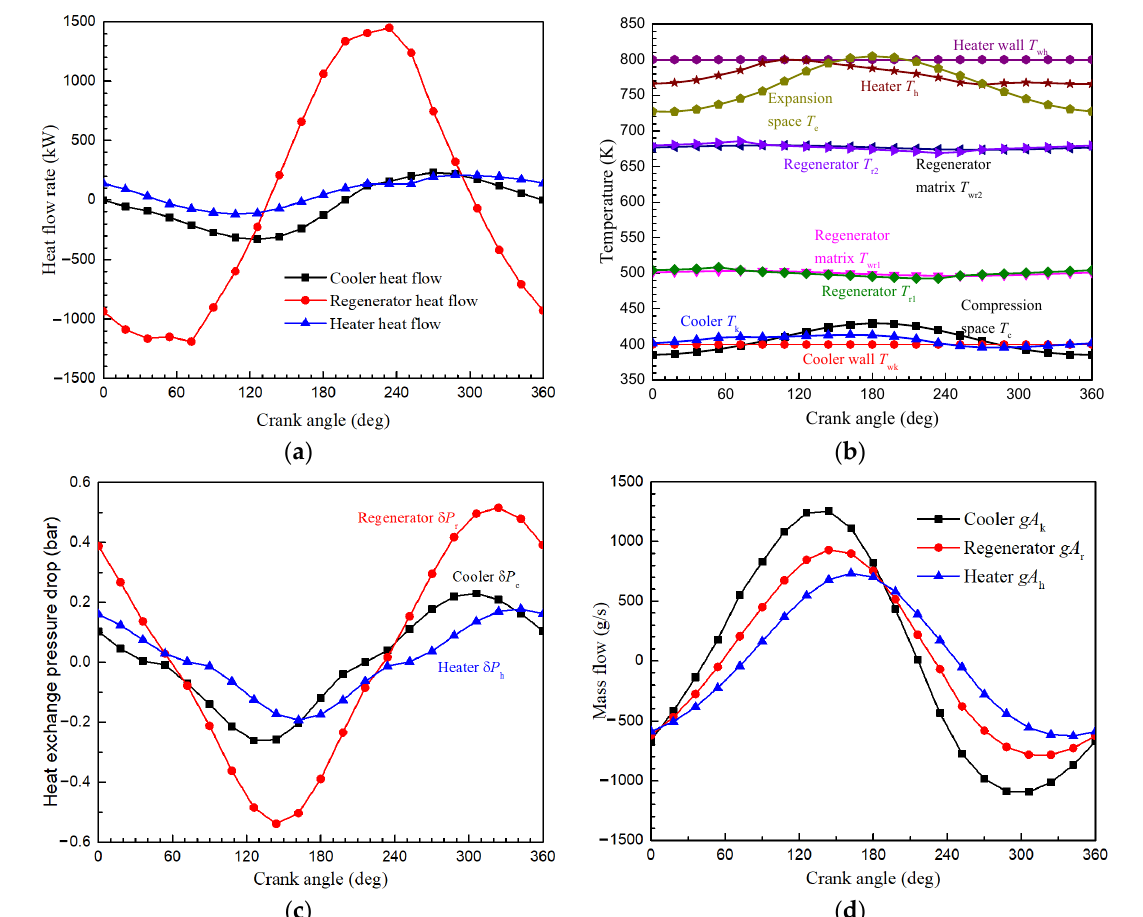
Figure 9. Results of the coupled model with losses for CTPC: ( a ) heat-flow rate, ( b ) temperature/theta, ( c ) Pressure drop, ( d ) Mass flow.